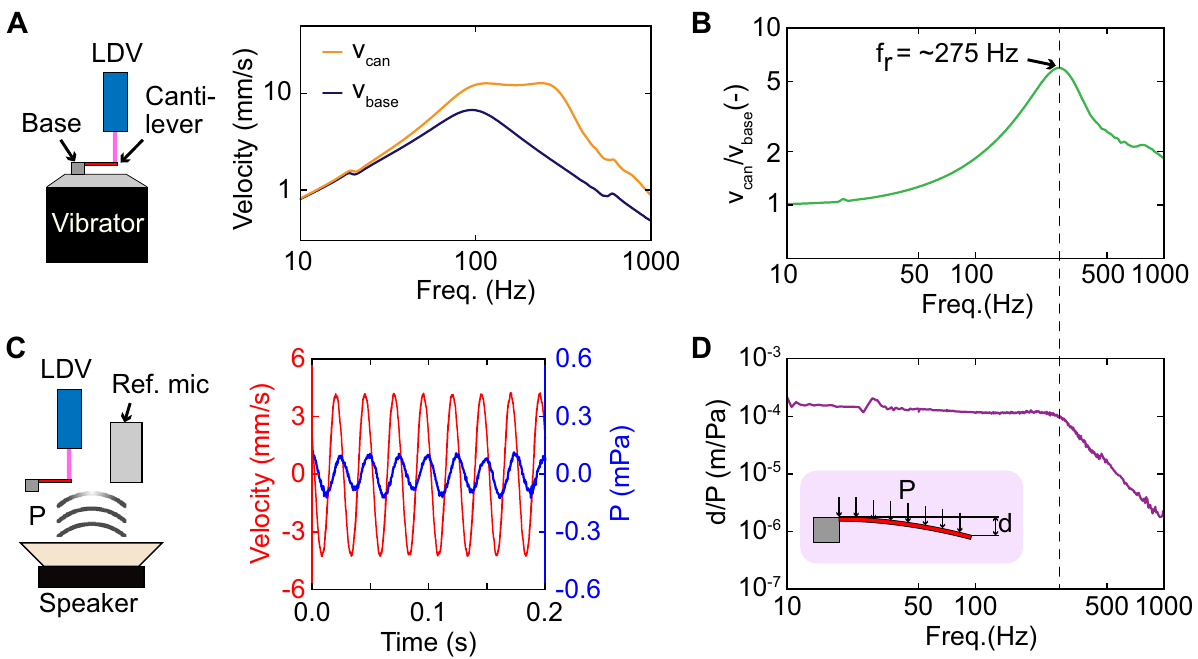
Figure 3. ( A ) Setup to measure the resonant frequency of the cantilever. ( B ) The frequency response characteristic of the cantilever in response to the vibration applied to the chip. V can and V base represent the vibration amplitudes of the cantilever and the chip base, respectively. ( C ) Raw data of the cantilever’s vibration and reference microphone output. ( D ) Frequency spectrum data of the cantilever’s vibration amplitude when the sound waves are